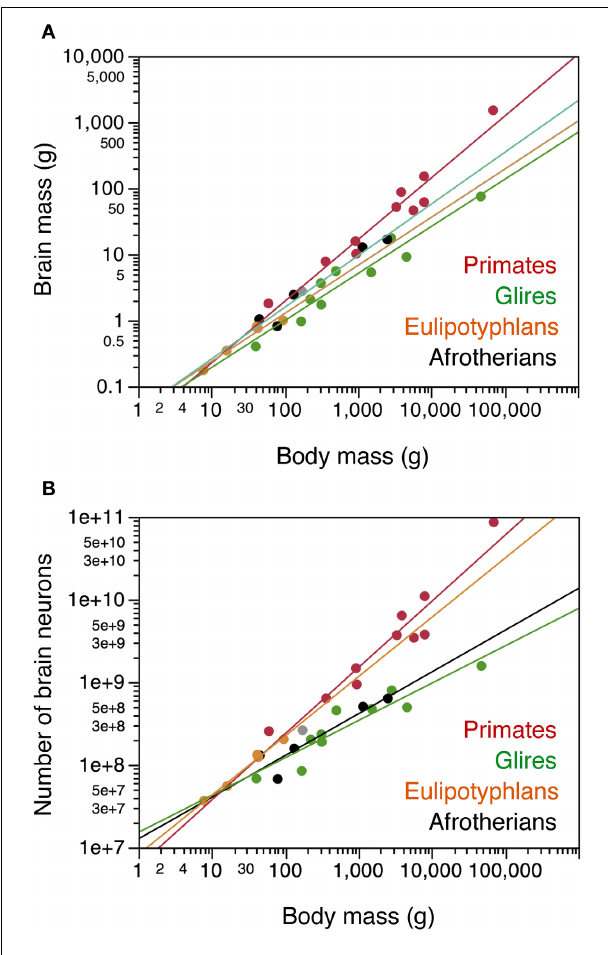
FIGURE 2 | Afrotherian brains gain mass similarly to Glires and eulipotyphlans, but gain neurons similarly to Glires and not to eulipotyphlans or primates. Scaling relationships for afrotherian brains (in black) are plotted along with rules found previously for other groups (primates in red, glires in green, eulipotyphlans in orange, scandentia in gray). Graphs relate (A) total brain mass (excluding the olfactory bulb) and (B) total numbers of neurons in the brain (excluding the olfactory bulb) to body mass. Each point represents the average values for each species. Data from Herculano-Houzel et al. (2006, 2007, 2011); Azevedo et al. (2009); Sarko et al. (2009); Gabi et al. (2010). Power functions for each group are plotted. Exponents for brain mass × body mass are 0.781 ± 0.101 (afrotherians), 0.712 ± 0.071 (Glires), 0.727 ± 0.094 (eulipotyphlans), 0.934 ± 0.068 (primates with Scandentia). Exponents relating number of brain neurons to body mass are 0.505 ± 0.113 (afrotherians), 0.451 ± 0.061 (Glires), 0.717 ± 0.045 (eulipotyphla), and 0.801 ± 0.084 (primates).